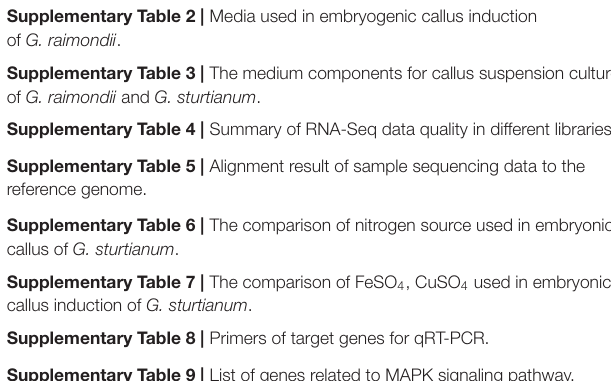
Supplementary Table 8 | Primers of target genes for qRT-PCR. Supplementary Table 9 | List of genes related to MAPK signaling